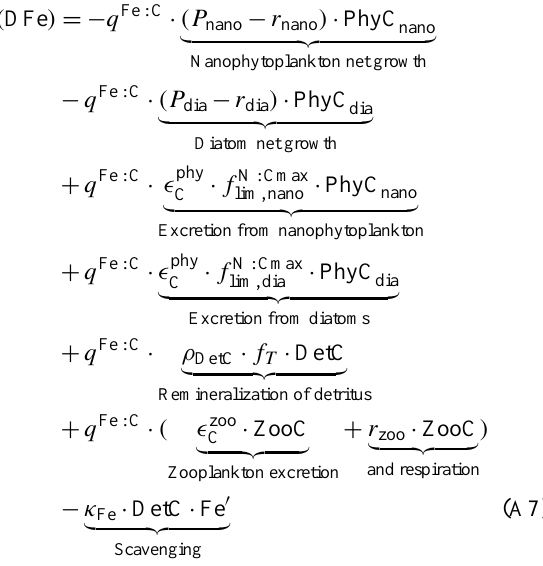
listed in Table A1. The value for the constant Fe : C ratio ( q Fe:C ) is listed in Table A6 and the DOC excretion rates from phyto- and zooplankton ( (cid:15) phy dation rate for detritus C ( ρ DetC ) are listed in Table A3.